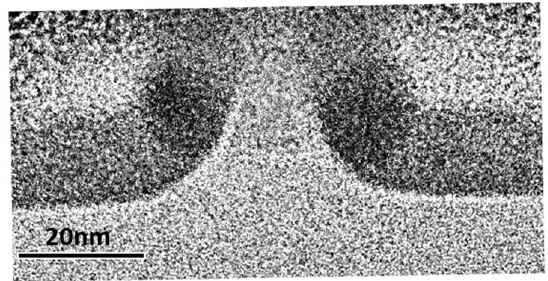
Figure 8. Cross-sectional TEM micrograph of symmetrical Ge DQDs with diameters as small as 12 nm and spacing between QDs as close as 13 nm formed by thermal oxidation at 900 °C for 27